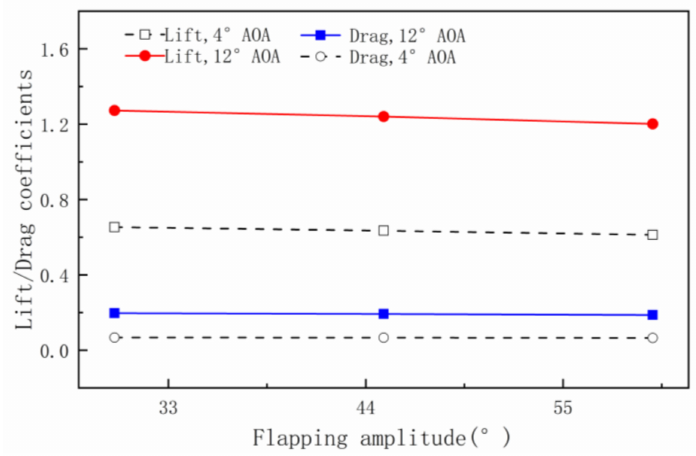
Figure 10. Comparisons of lift/drag coefficients with flapping